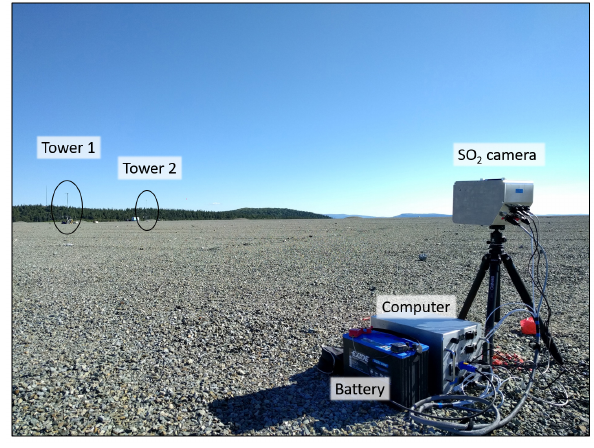
Figure 3. SO 2 camera and PC (camera 5). In the background, the release and measurement towers are